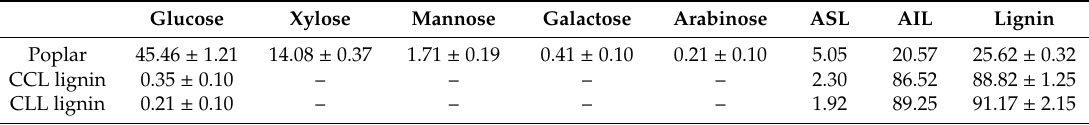
Table 3. Purity of the DES lignin extracted from poplar as a percentage based on the testing sample. Glucose